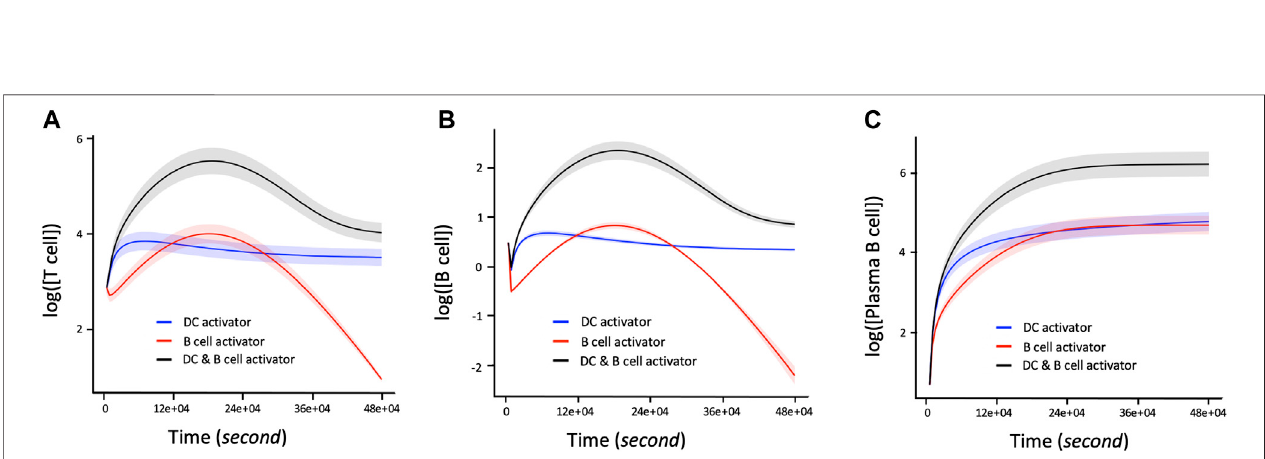
FIGURE 5 | Time dependent Lymphocyte immune response with respect to three activation protocols: DC activation, B cell activation, joint activation of DC and B cells. The corresponding concentration of IL-2 and IL-4 used are 1.5 and 15pM respectively. (A) Log 10-time dependent changes in number of T cells in terms of DC activator,Bcellsactivators,andthejointDCandBcellsactivations. (B) Log10ofchangesinnumberofBcellsovertimewithregardstoDCactivator,Bcellactivatorand the joint DC and B cell activator. (C) Rate of change of proliferation values in Log 10 scale corresponding to the number of Plasma B cells per unit time in seconds withrespect tothe DC activator, B cell activator, and the jointDC and B cells activator. The shaded area of the levels of T cells, B cells and Plasma B cells in (A) , (B) , and (C) respectively represent the con fi dence interval at 95% con fi dence level.